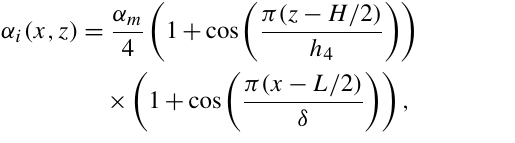
Table A1. Convergence rates in (cid:107)·(cid:107) 1 and (cid:107)·(cid:107) 2 for Case 4. Con- vergence rates for the DL99 scheme, marked with a ∗ symbol, are evaluated between nx = 40 and nx = 80, before numerical oscilla- tions appear and begin to degrade the result. Horiz.